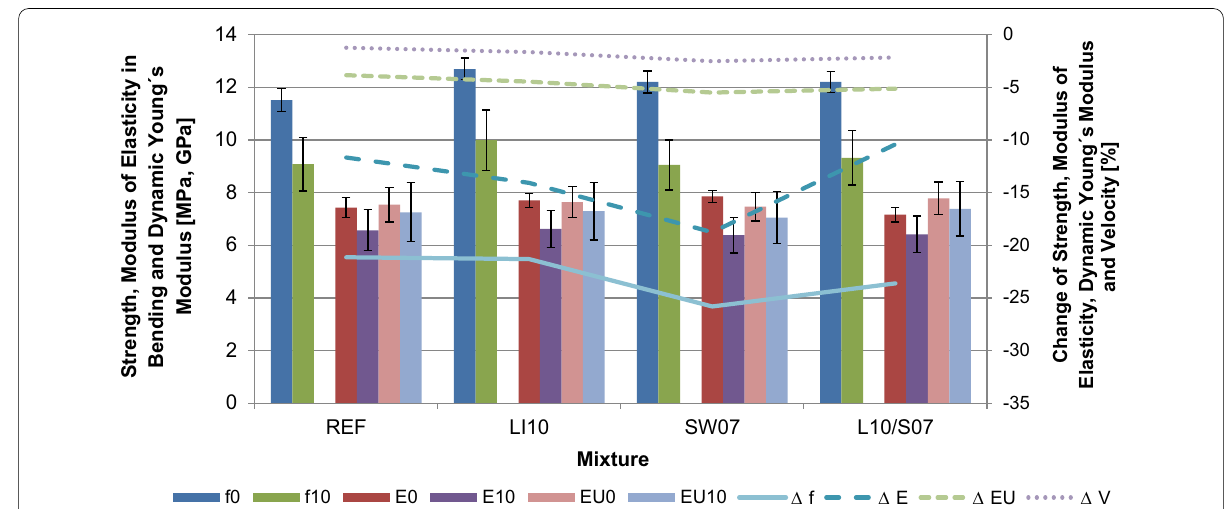
Fig. 17 Comparison of changes of bending strength, modulus of elasticity and dynamic Young´s modulus of elasticity before and after 10 wet– frost–dry